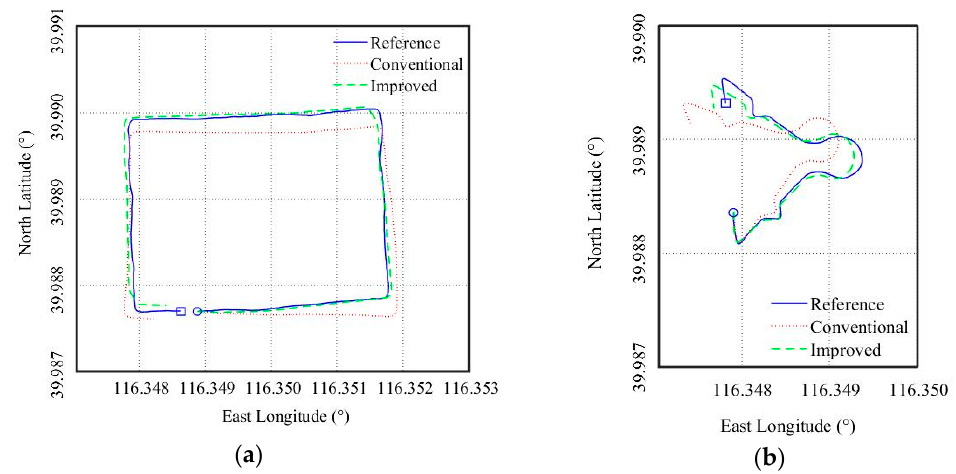
Figure 11. Dead reckoning results. The circle represents the start point, and the square represents the end point. ( a ) Trajectory A. ( b ) Trajectory B.